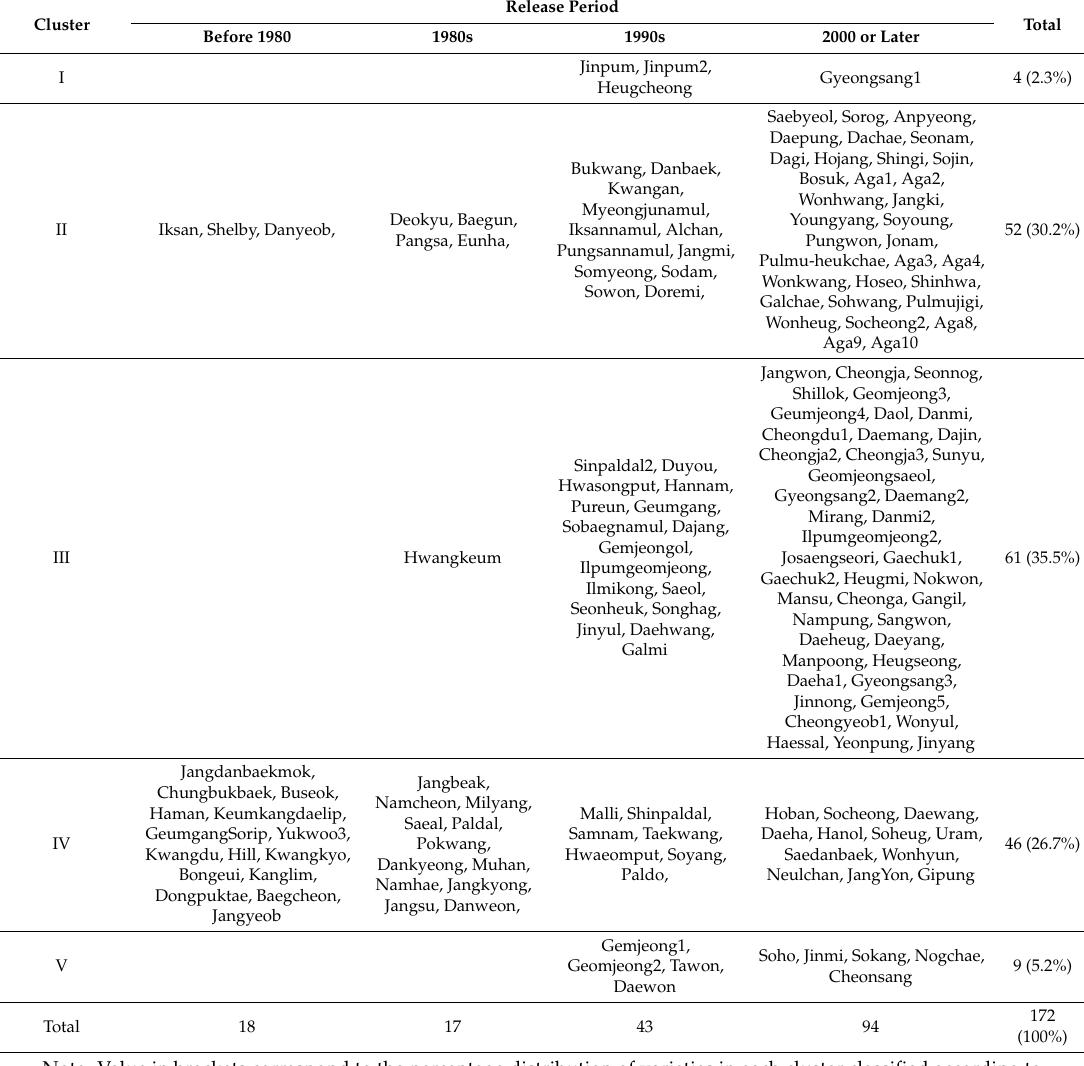
Table 4. List of varieties in each cluster classified by release years using SSR markers in 172 Korean soybean varieties.